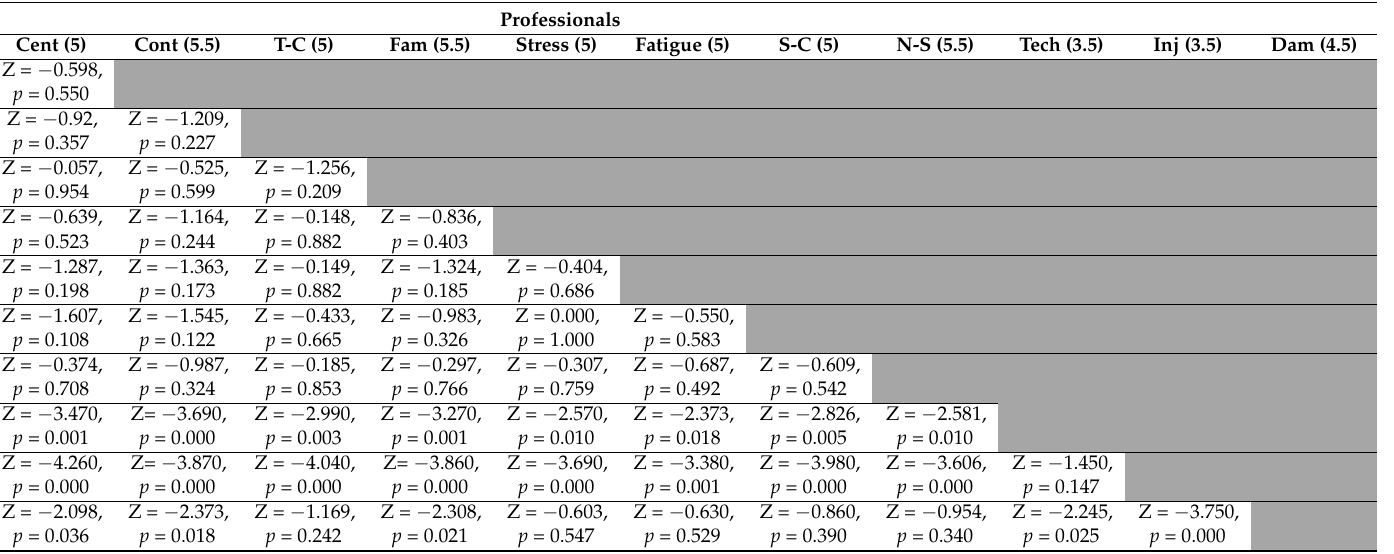
Table A5. Differences in risk perception factors within